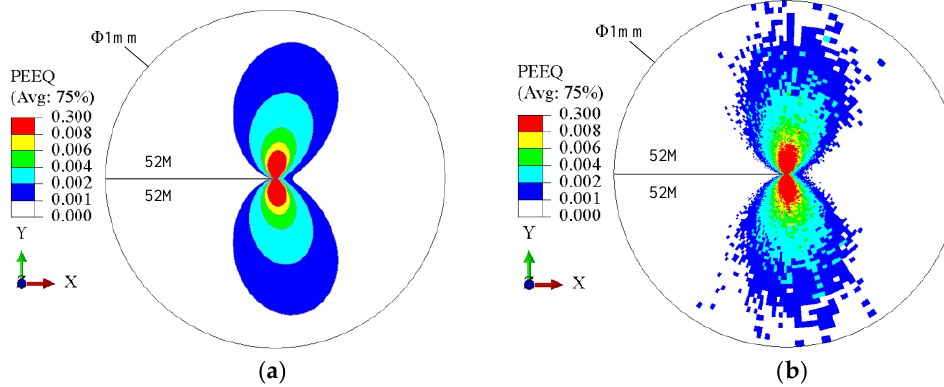
Figure 8. Equivalent plastic strain at the tip of crack 1: ( a ) homogeneous; ( b ) inhomogeneous.